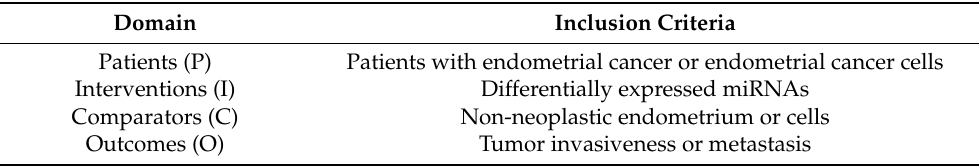
Table 1. PICO question